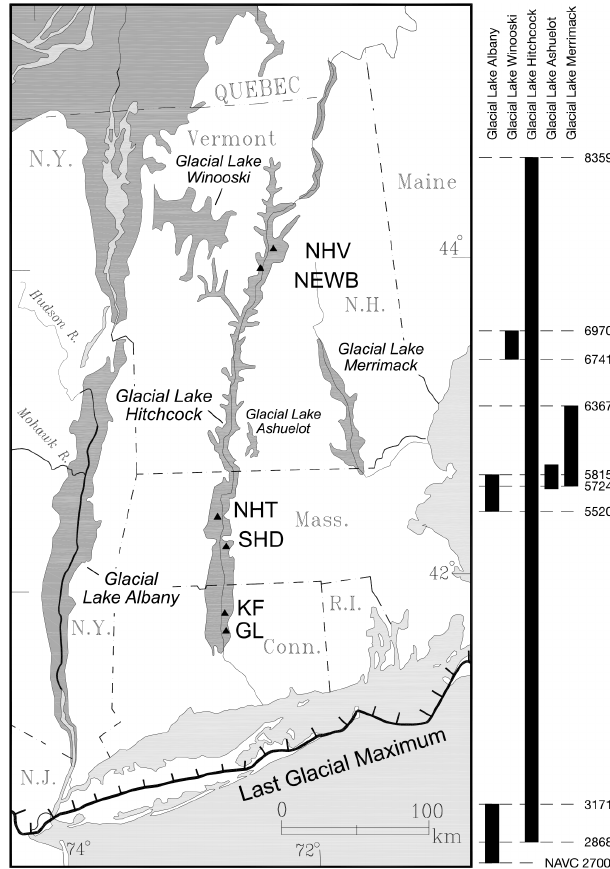
Figure 1. Map of New England and adjacent parts of the east- ern United States and Canada showing the location and extent of the NAVC (Ridge et al., 2012). The NAVC consists of sediments from several proglacial lakes that existed at different times. The dark shaded areas show the maximum extent of major proglacial lakes present during deglaciation, although lake boundaries were time-transgressive throughout deglaciation and these do not repre- sent exact lake boundaries at a specific time. Labeled triangles show the location of sections sampled for this study (the abbreviations fol- low Table 1), with the exception of 930PN, which is located off the map to the west in central New York. Nearly the entire time span of the NAVC is represented by sediments from Glacial Lake Hitch- cock, and sequences from other nearby glacial lakes are correlated with the Lake Hitchcock sequence as shown in the stratigraphic di- agram at right. Although lake sediments at any particular point span a range of NAVC years, deglaciation of the area proceeded from south to north, so, in general, younger (higher-numbered) varves are found at more northerly sites (Fig.